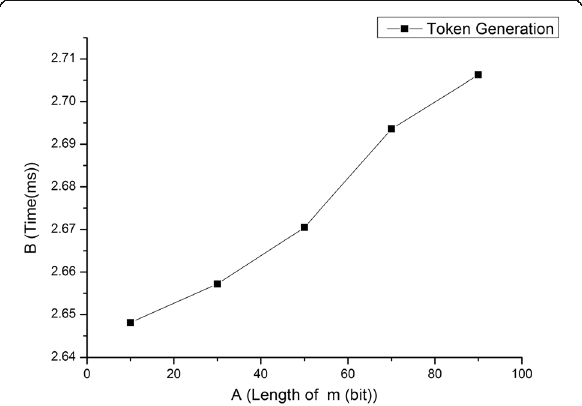
Fig. 2 Time cost of token